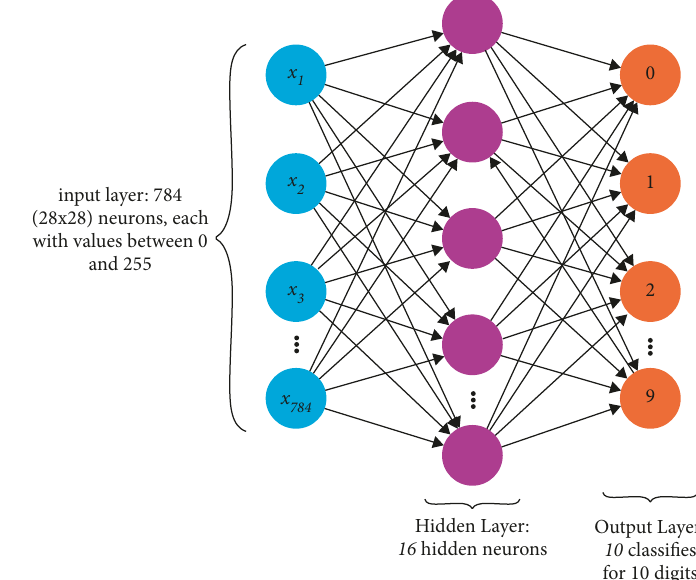
Figure 8: Multilayered artificial neural networks